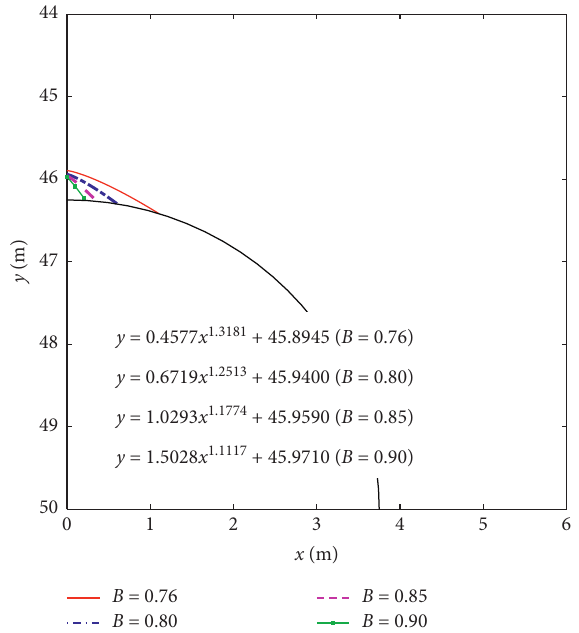
Figure 6: Effect of material parameter B of Hoek–Brown criterion on collapse mechanisms. The parameters are A � 0.35, σ c � 3 × 10 4 kPa, σ t � σ c /100 � 300kPa, h w − h t � 16.68m, r � 3.75m, C � 50m, and c sat � 28.33kN/m 3